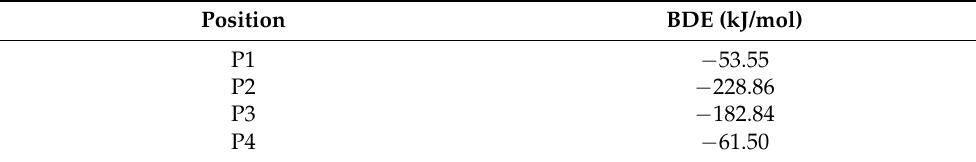
Figure 5. Optimized geometries of the oxygen molecule: ( P1 ) on top of the Au surface, ( P2 ) on top of the attached Ph-COOH moiety, ( P3 ) bridge on the Au surface, ( P4 ) fcc-hollow (level of theory: GGA/DND/TS). Table 2. BDE for different optimized energies of oxygen molecules interacting on the grafted gold surfaces (level of theory: GGA/DND/TS).